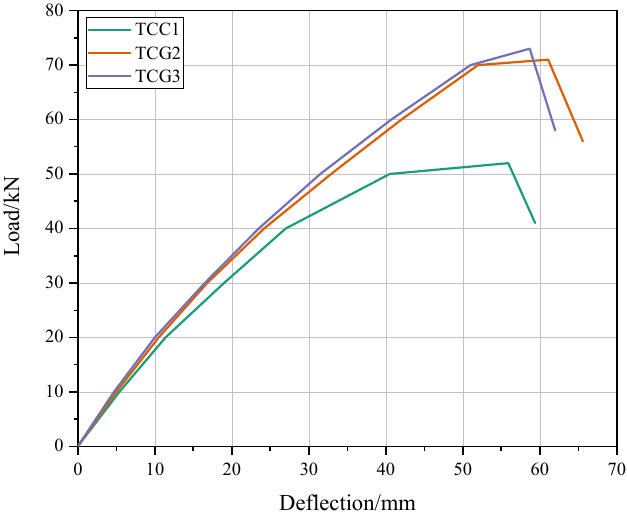
Figure 13. Load-deflection curves of composite boards.